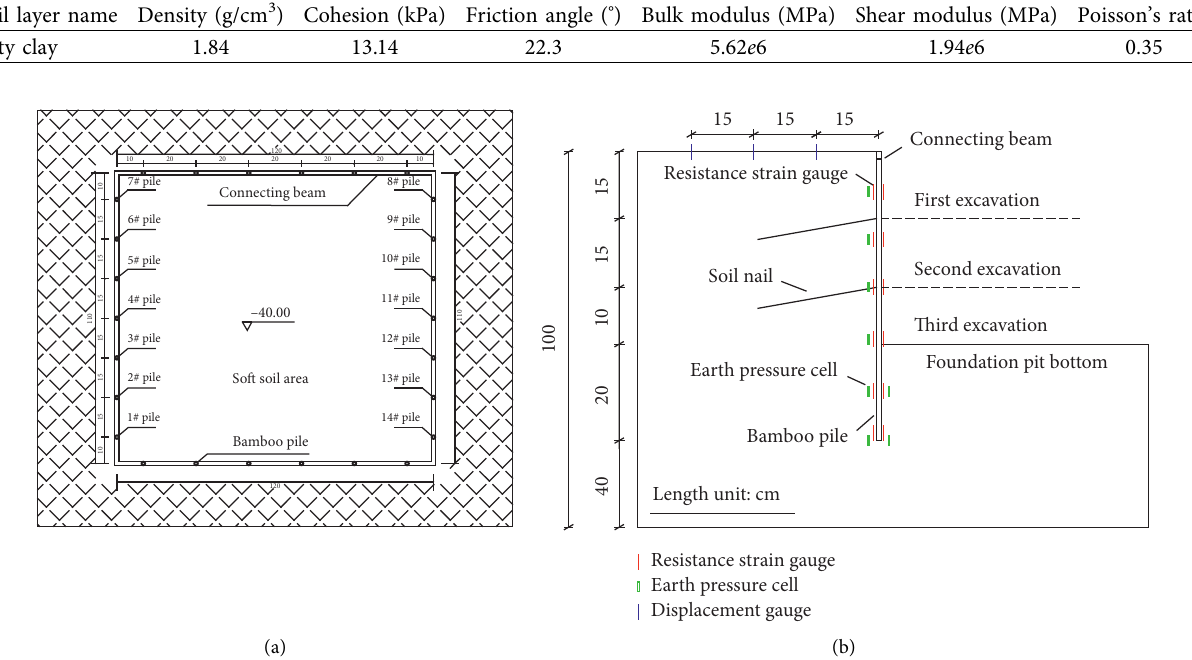
Table 1: Physical and mechanical properties of the soil sample.